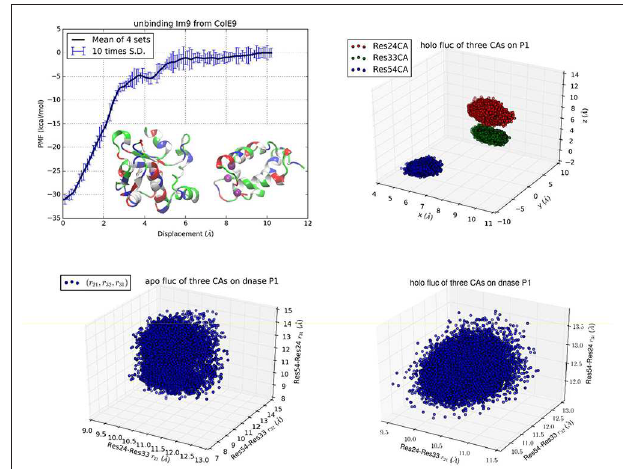
FIGURE 2 | Unbinding Im9 immunity protein from Colicin E9 DNase with Protocol 2. Shown in the upper left panel is the PMF curve of unbinding Im9 from E9. Insets: Im9 and E9 in the unbound state are shown in ribbons colored by residue types (hydrophobic, white; hydrophilic, green; negatively charged, red; positively charged, blue). The three centers ( α -carbons) on Im9 (Asn24C α , Leu33C α , and Tyr54C α ) are marked as purple balls, whose coordinates represent the position and orientation of Im9. The upper right panel shows the fluctuations of the three centers in the bound state in terms of their coordinates: ( x 1, y 1 , z 1 ), ( x 2, y 2 , z 2 ), and ( x 3, y 3 , z 3 ). The lower left/right panel shows their fluctuations in the unbound/bound state in terms of three mutual distances: ( r 21 , r 32 , r 31